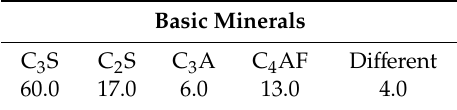
Table 2. Contents of basic minerals, mass%.